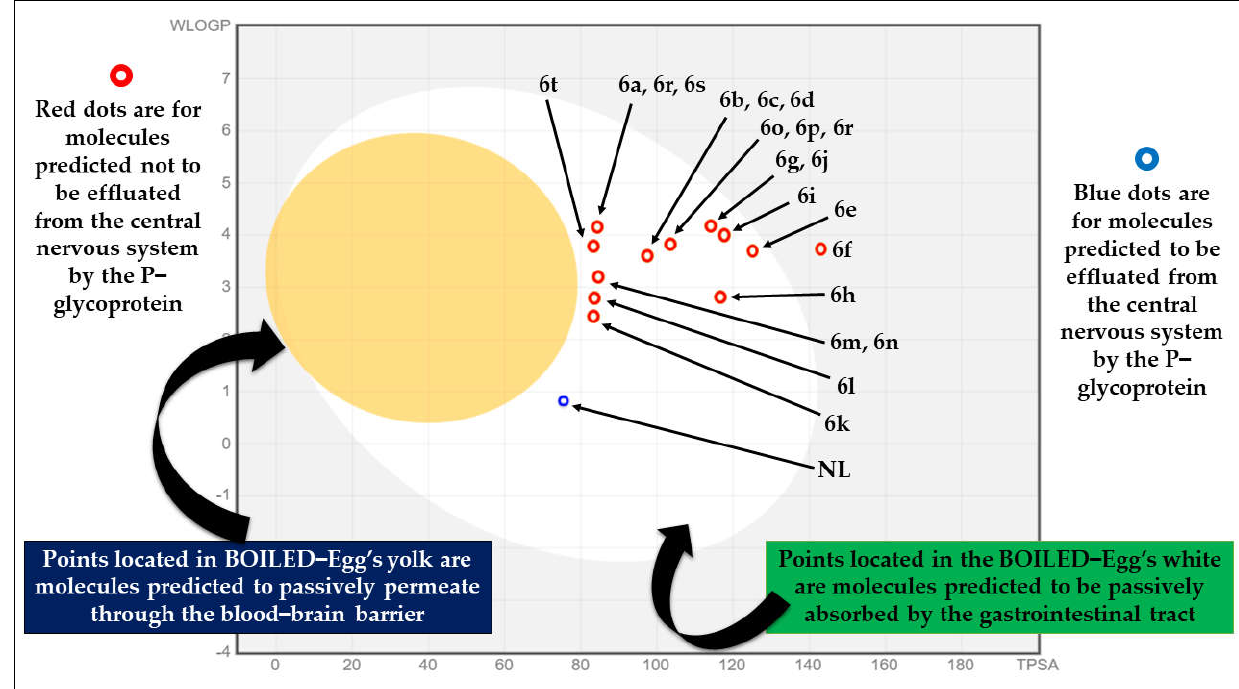
Figure 4. The BOILED-Egg plot of designed molecules obtained from the SwissADME online server, presented with modifications. (Note: BOILED-Egg plot of each molecule is given in Table S4 in the Supplementary Information).